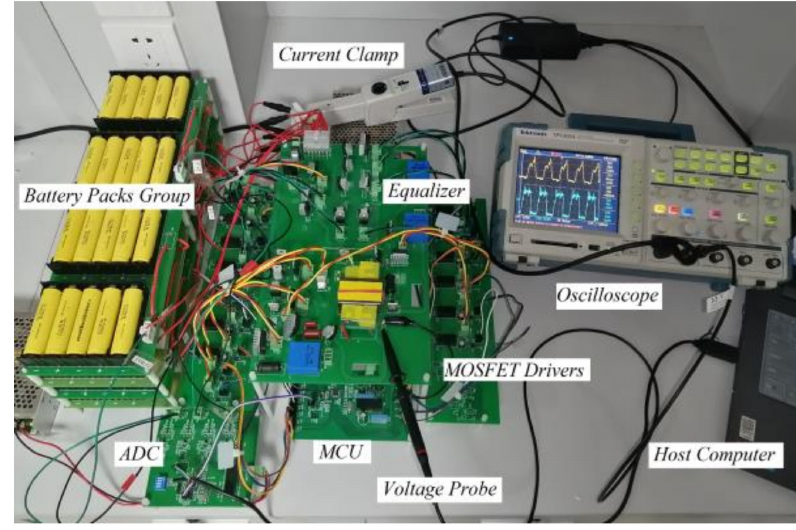
Figure 7. Photograph of the experimental prototype. Table 5. Component parameters of prototype.